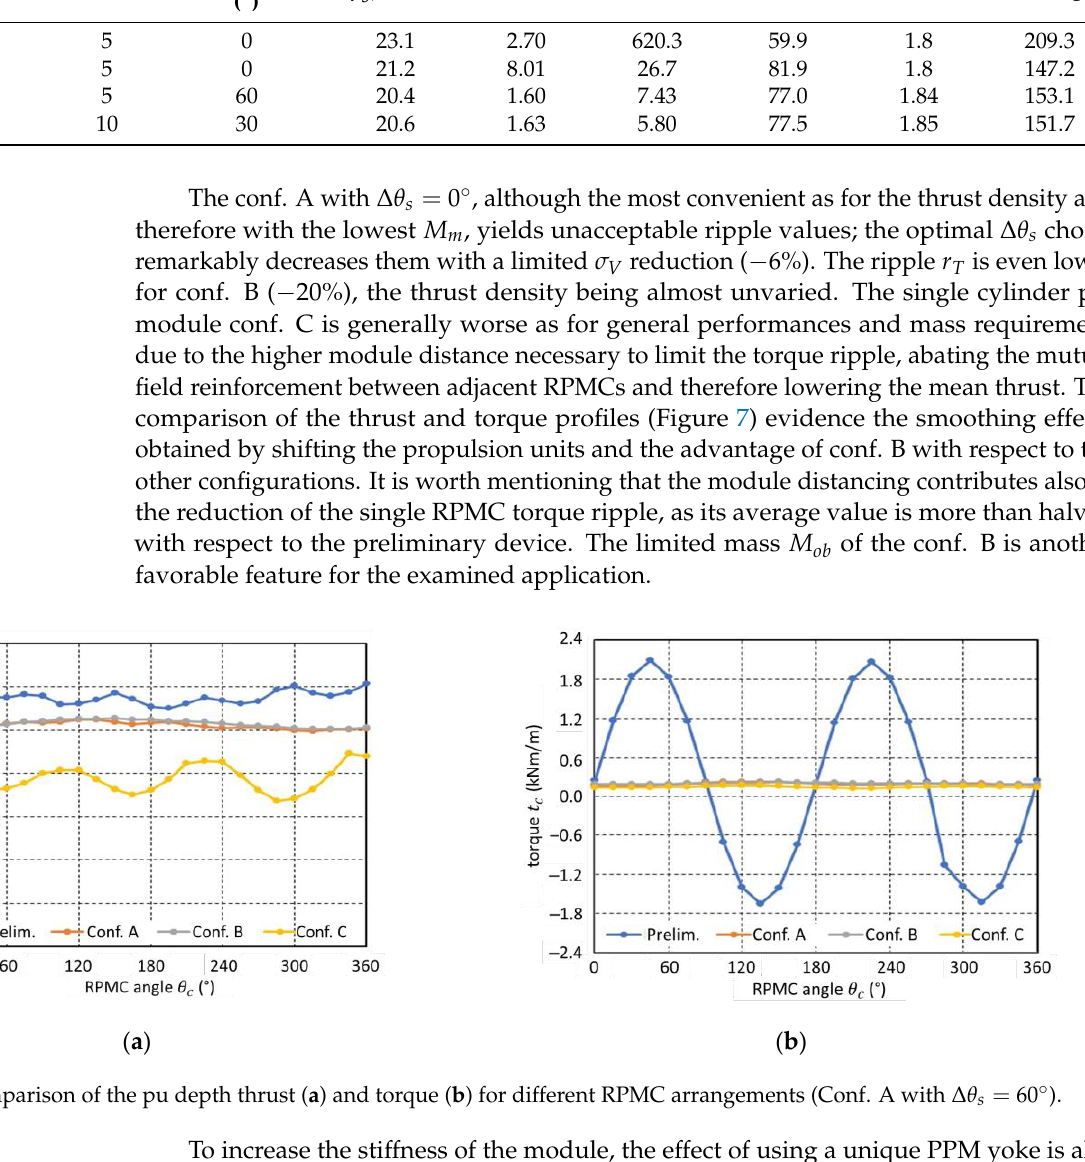
Table 4. Comparison between different RPMC arrangements.